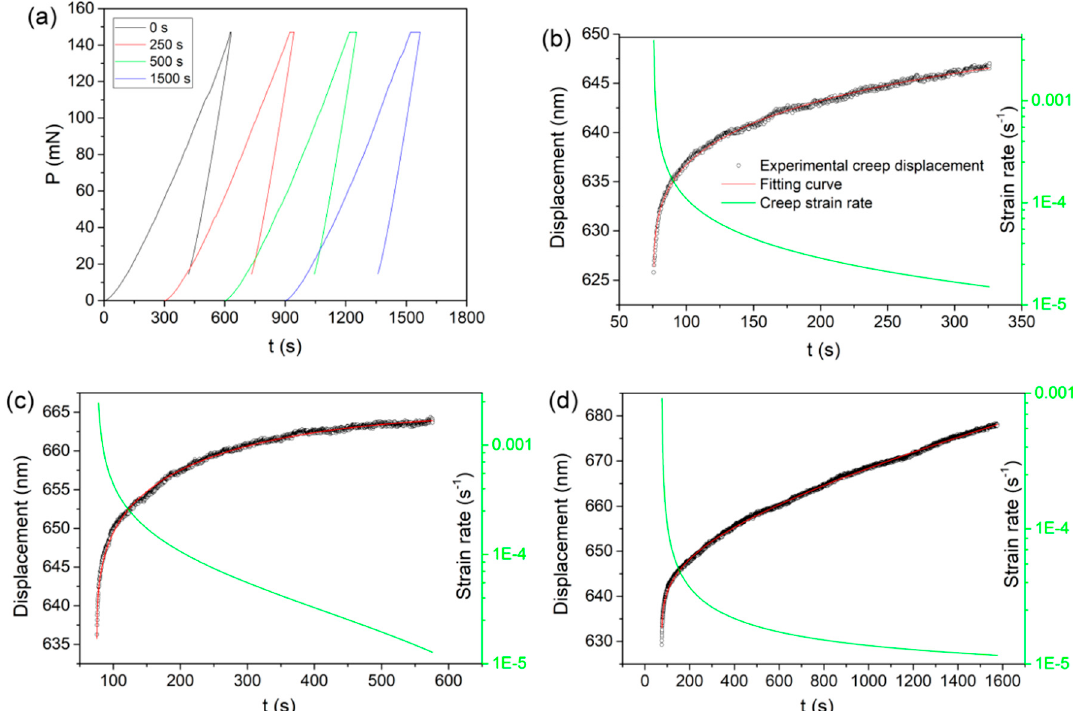
Figure 3. ( a ) Typical P - h curves of load-holding tests with various duration and the time-dependent plastic deformations were plotted as a function of holding time ( b ) 250 s, ( c ) 500 s and ( d ) 1500 s. An empirical law was adopted to fit the creep curves and the corresponding strain rate could be deduced. Both creep fitting line and strain rate were plotted as a function of holding time.